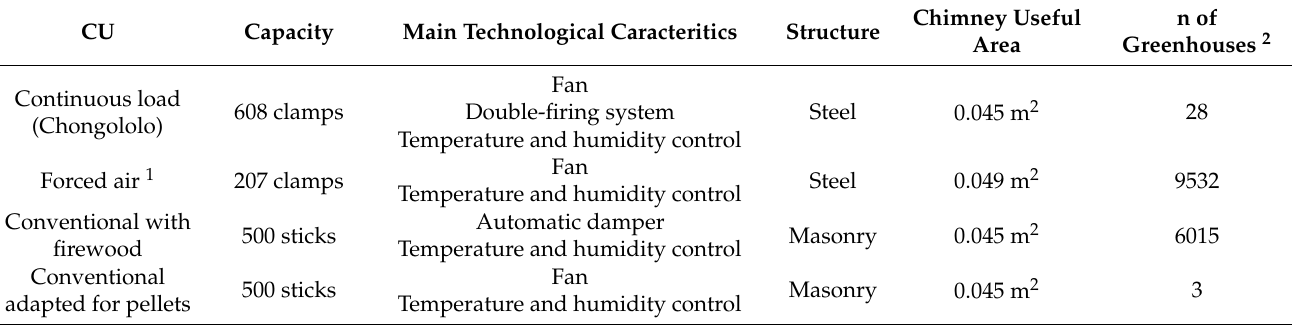
Table 1. Characteristics of the curing/drying units